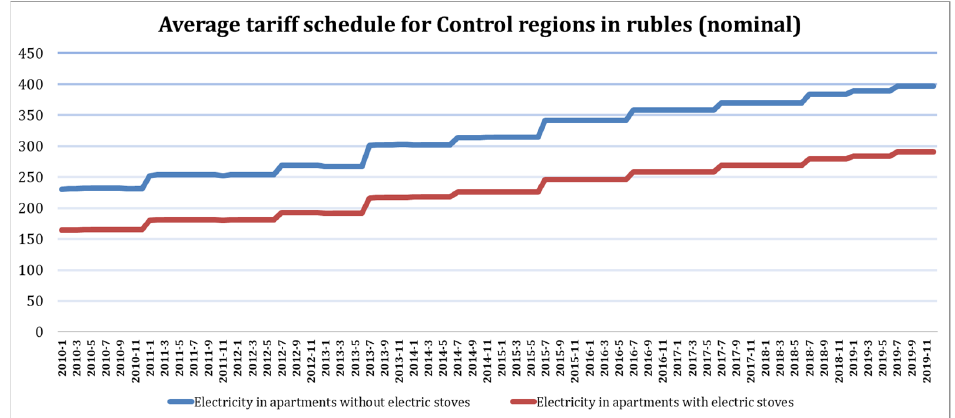
Figure A3. Electricity Tariff Schedule Nizhny Novgorod (2010–2019). Source: Federal State Statistics Service.